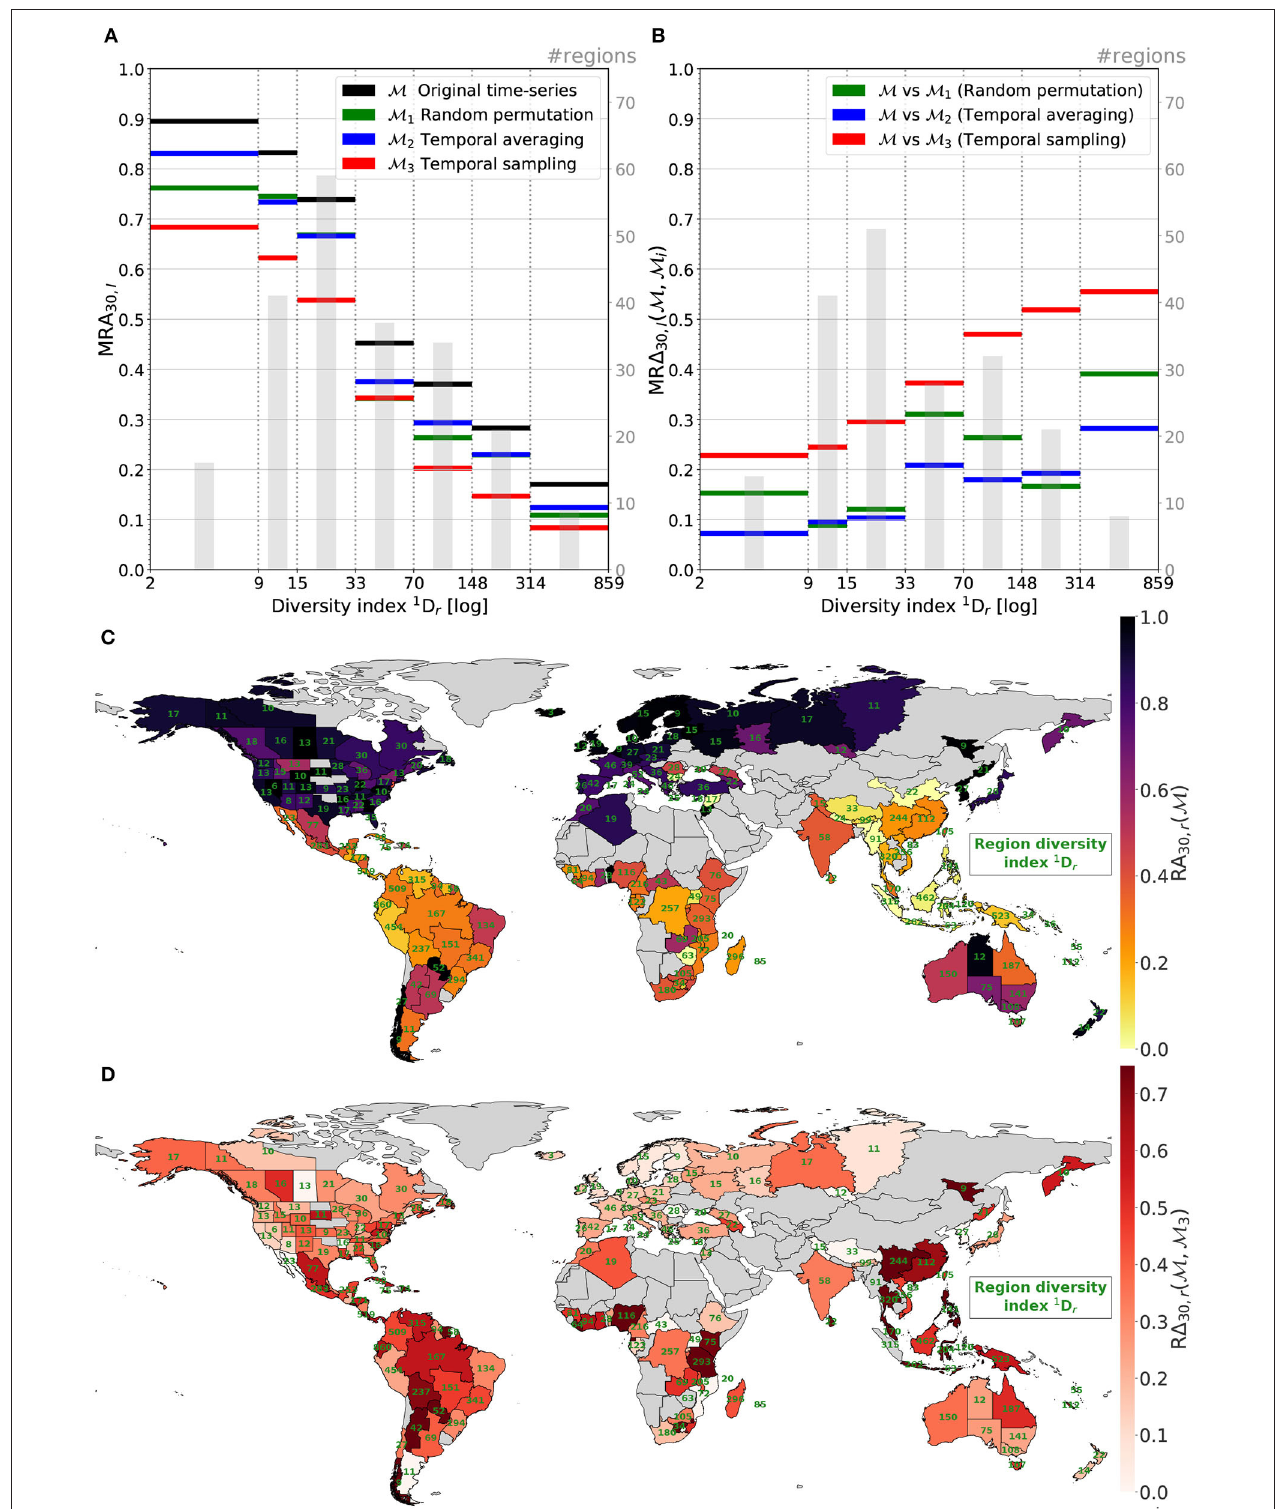
FIGURE 10 | Region top-30 accuracy (A) and relative top-30 accuracy change (B) averaged per cat. of 1 D r . Map (C) presents region top-30 accuracy with 1 D r indicated in green. Map (D) illustrates spatial decreases in performances when comparing M 3 to M , i.e., without/with the temporal information.